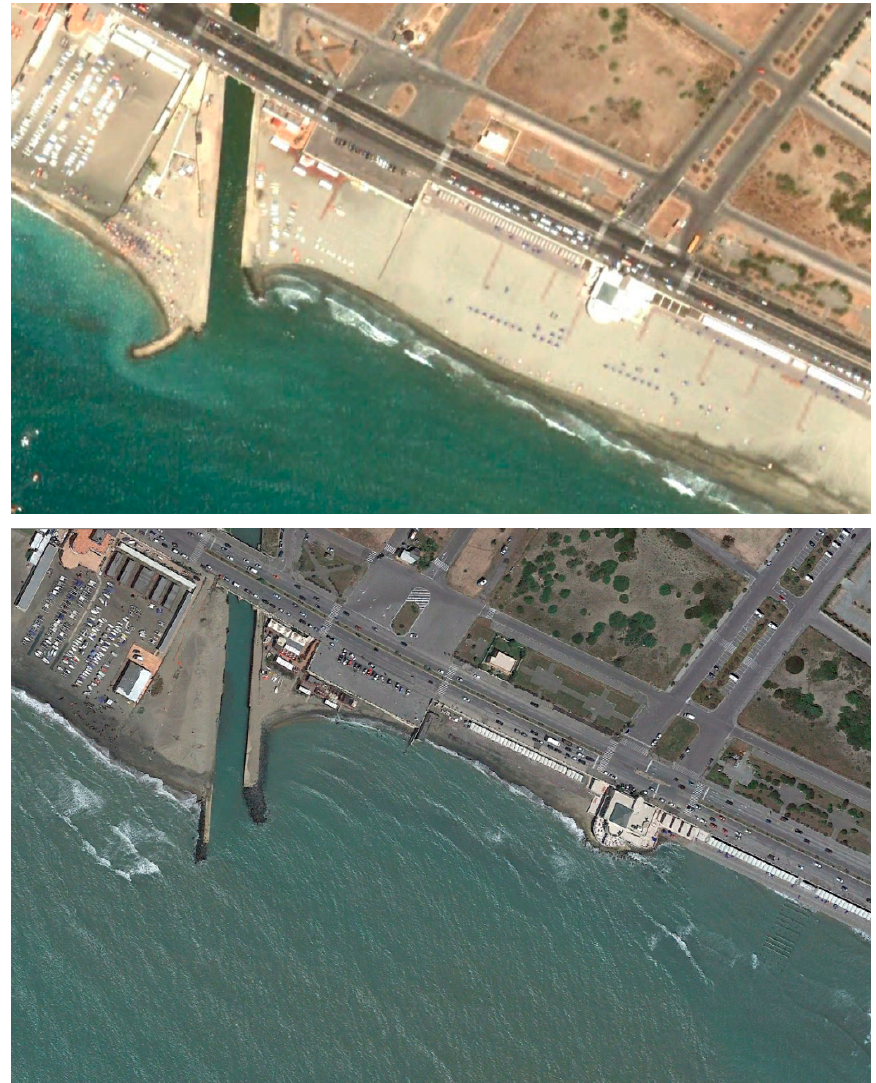
Figure 2. Beach erosion at the Canale dei Pescatori inlet at Ostia (Rome). Upper figure: July 2003, after a large, unprotected sand nourishment. Lower figure: April 2017. Approximate size of the framed area: 500 × 320 m. North is aligned with upwards direction of the figure. Both figures are taken from the Google Earth web site Table 1. Existing wave buoy measurements in the area (see map in Figure 1). Wave data in italics was not used in this study. Station Location Owner/Manager Depth. (m) Information Time